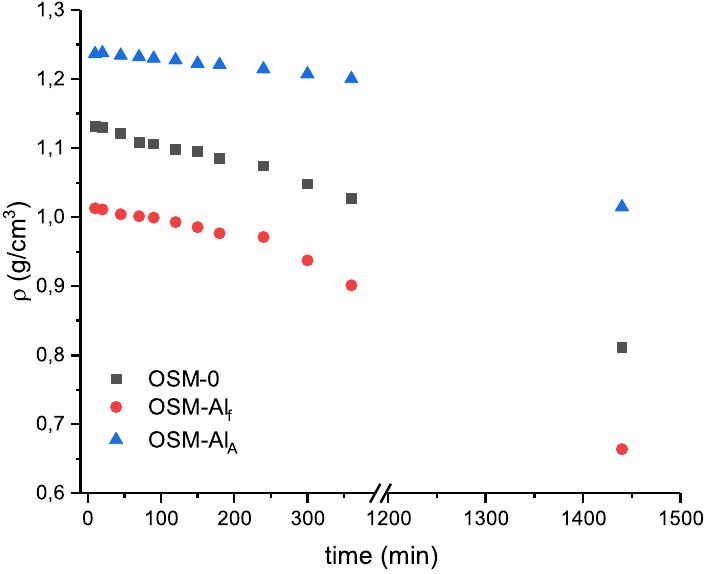
Figure A5. Evolution of OSM density over time elapsed after their